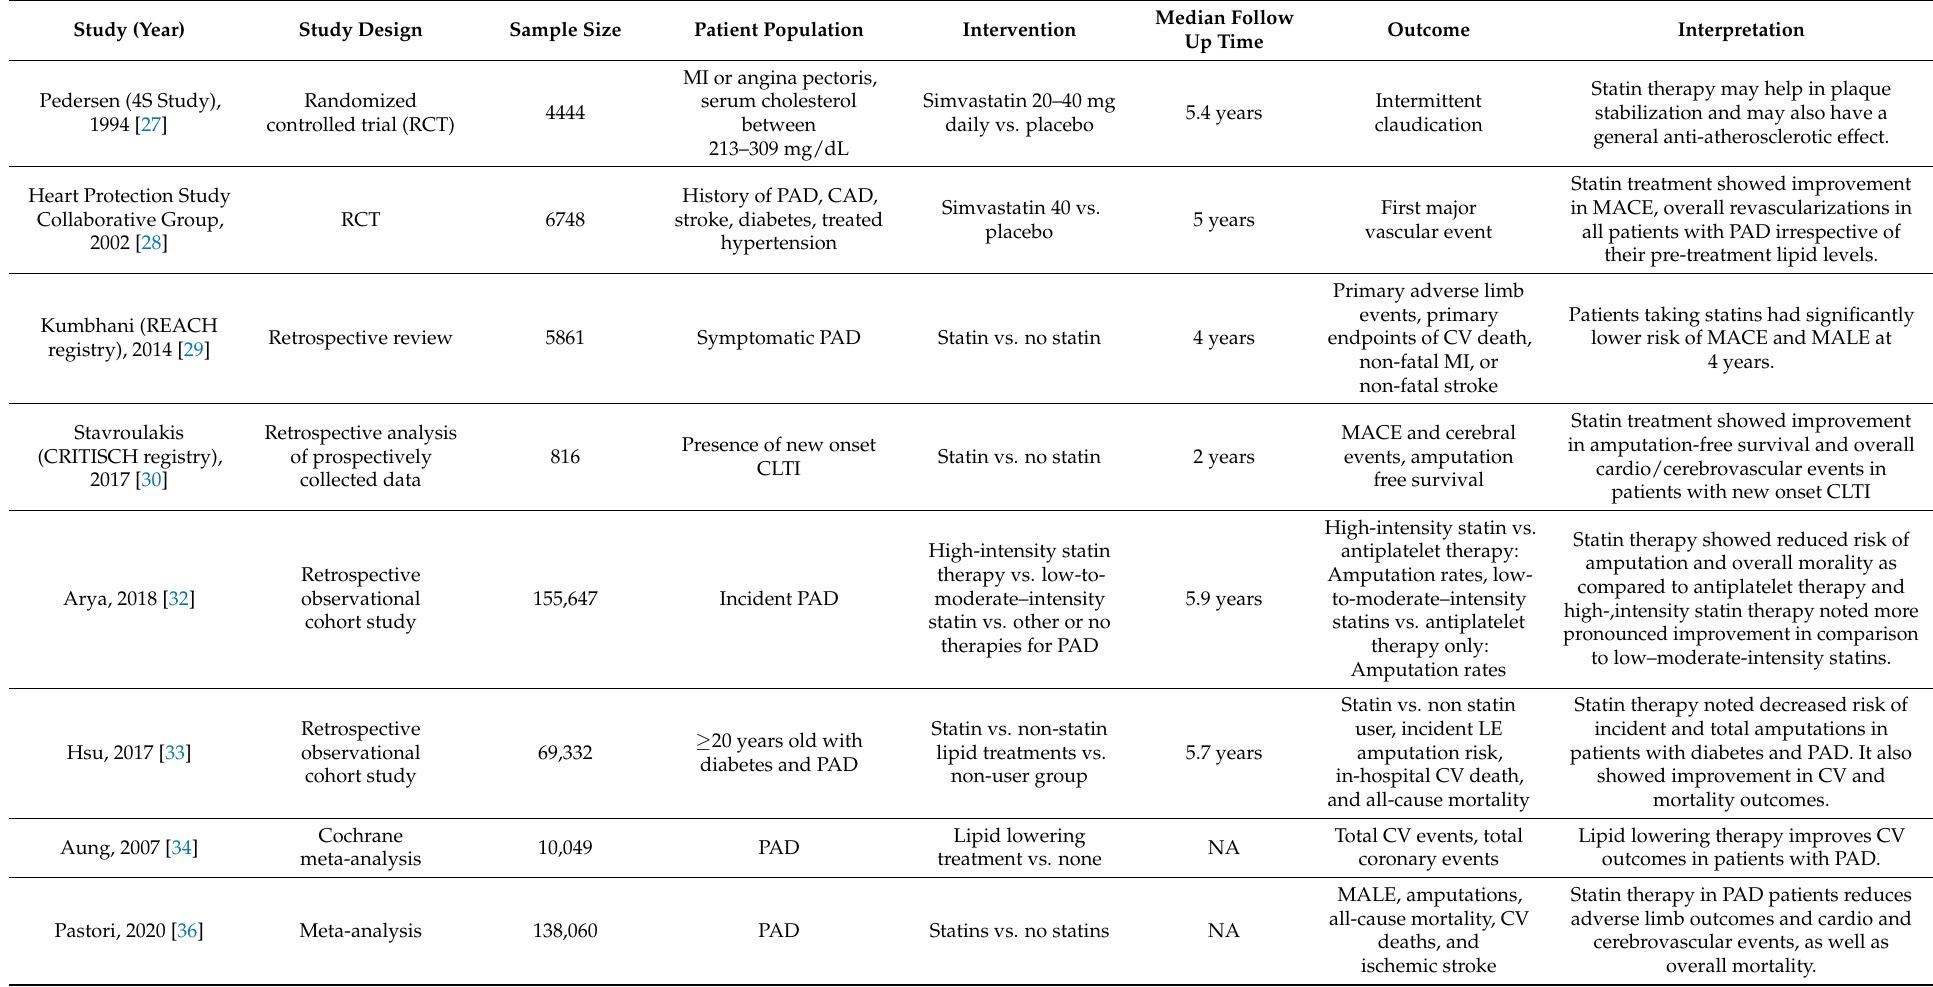
Table 1. Summary of landmark studies on the role of lipid-lowering therapy in